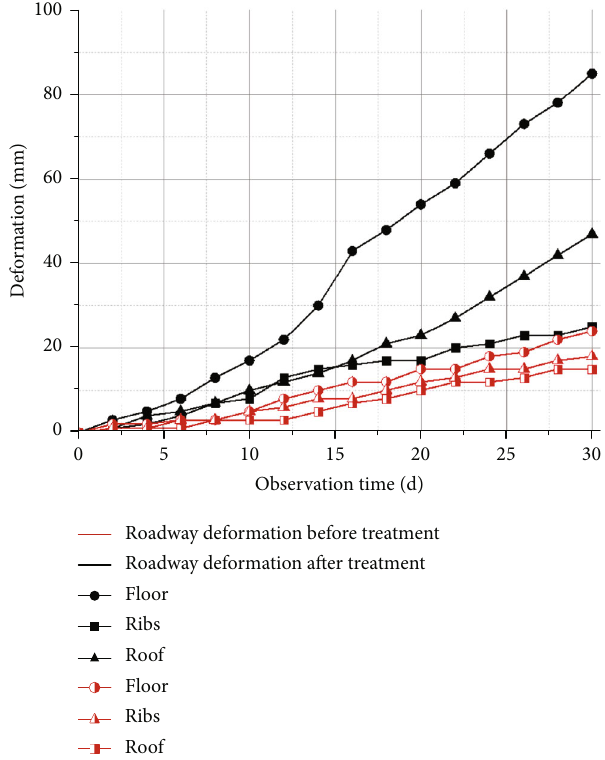
Figure 15: Monitoring curve of engineering